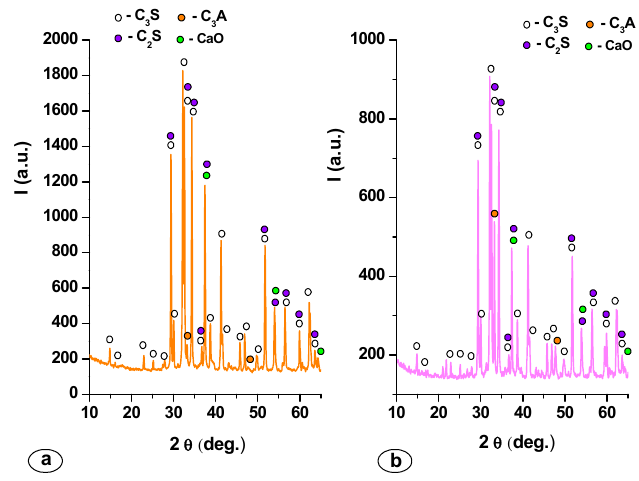
Figure 2. XRD patterns of MTA cements: ( a ) MTA1 and ( b ) MTA2.